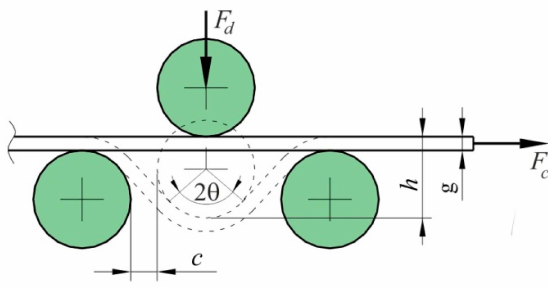
Figure 5. Geometric parameters of the